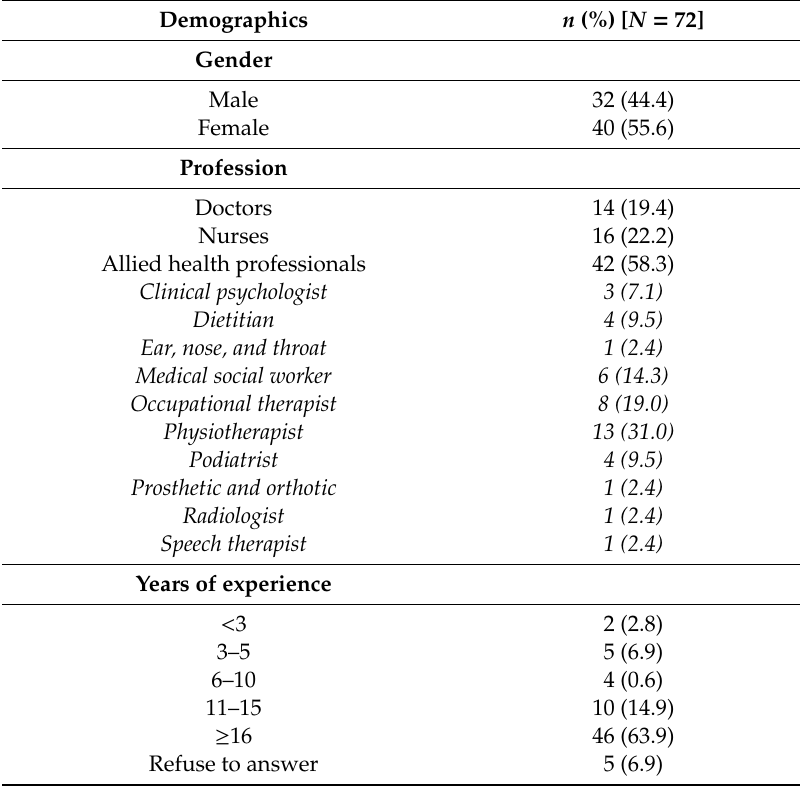
Table 1. Demographic characteristics of